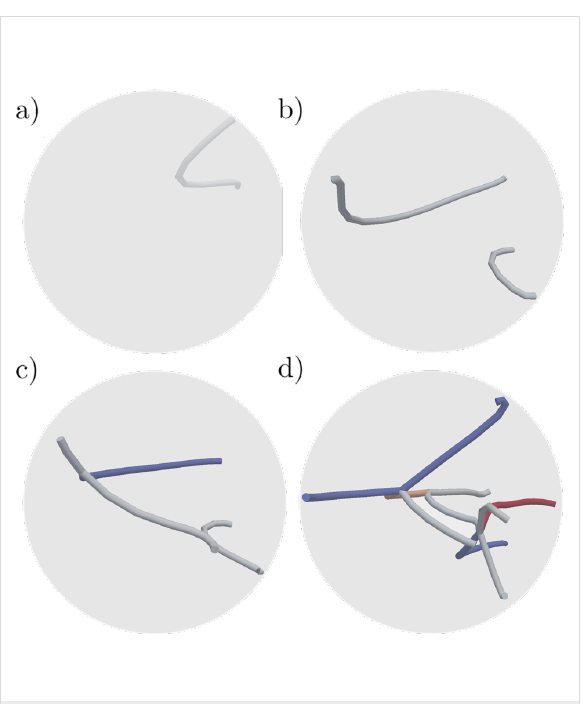
Figure 5: Dislocations interacting at the onset of plasticity. Colouring by the length of the Burgers vectors, red | <312>|, grey | <112>|, and blue | <110>|. (a–b) Shockley partials are nucleated 2.5 ps apart at the onset of plasticity. (c) Nucleation of a third dislocation leads to the formation of a stair-rod dislocation. (d) Nucleation of multiple dislo- cations leads to the formation of dislocation dendrite inside the particle blocking the dislocation nucleation and